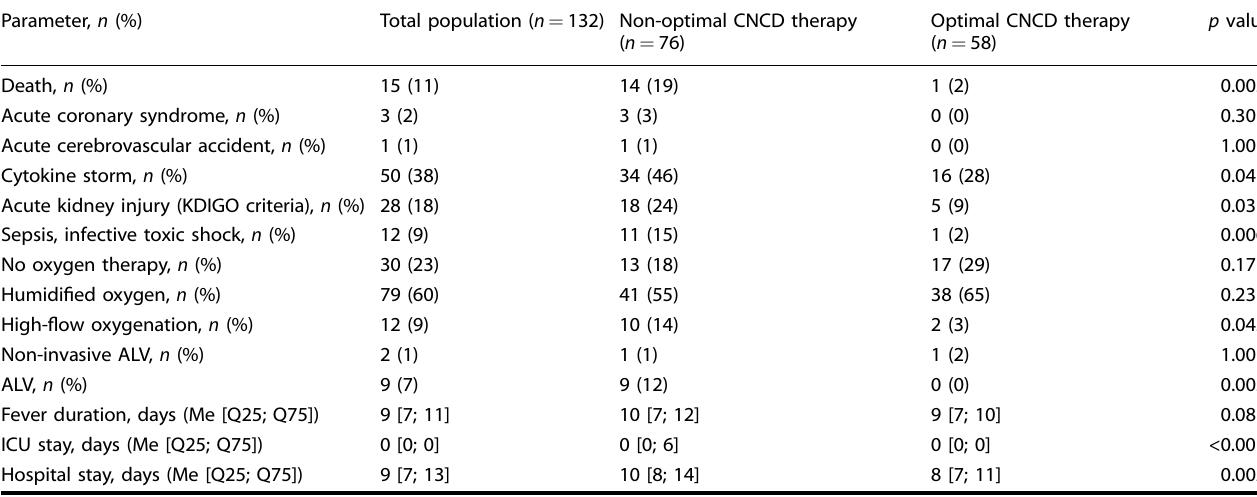
Table 4. Study groups by the course and outcome of COVID-19.